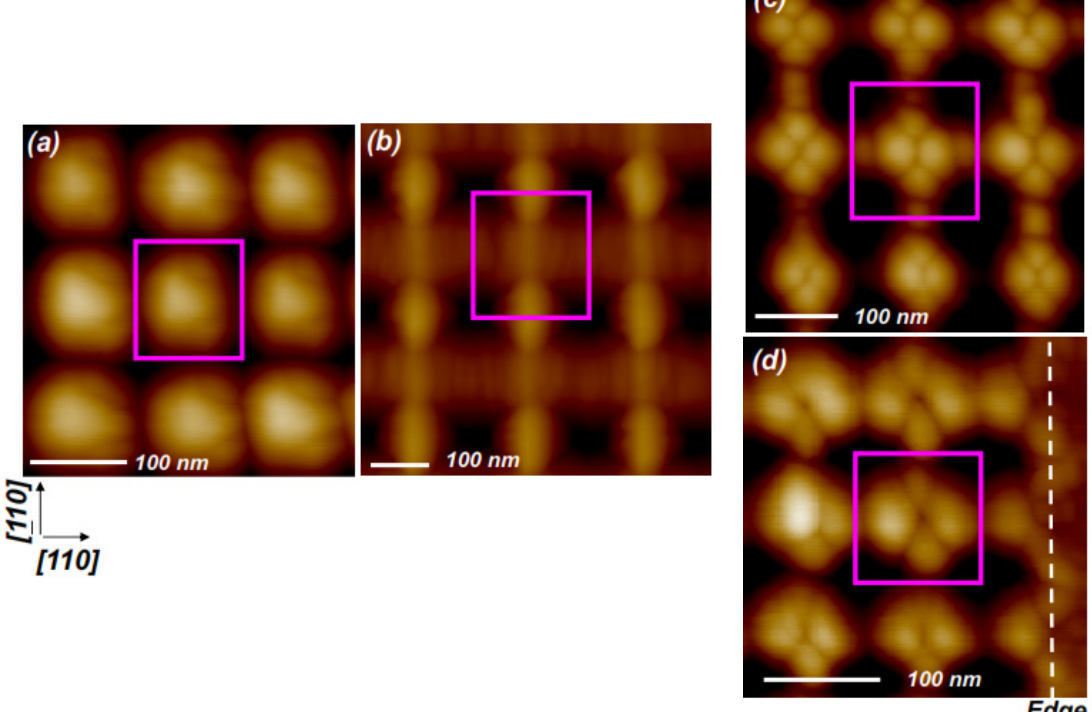
Figure 2. Temperature and lateral spatial periodicity ( λ ) dependence of directing self-assembly of mound structures ( a ) growth at 525 °C, λ = 120 nm; ( b ) growth at 460 °C, λ = 200 nm; ( c , d ) growth at 300 °C on nanopit-patterned surface with lateral spatial periodicities of 160 nm, and 120 nm, respectively. The dashed line in 2d marks the edge of the patterned